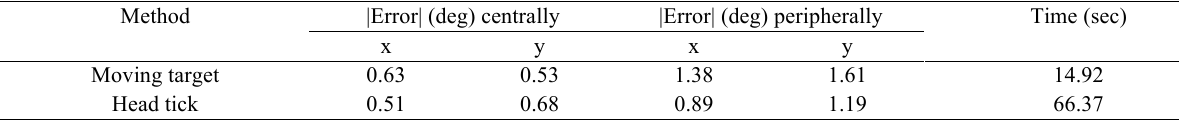
Mean calibration error (in degrees of visual angle) and time for moving target and head tick methods, averaged across 13 central points and 12 peripheral points.